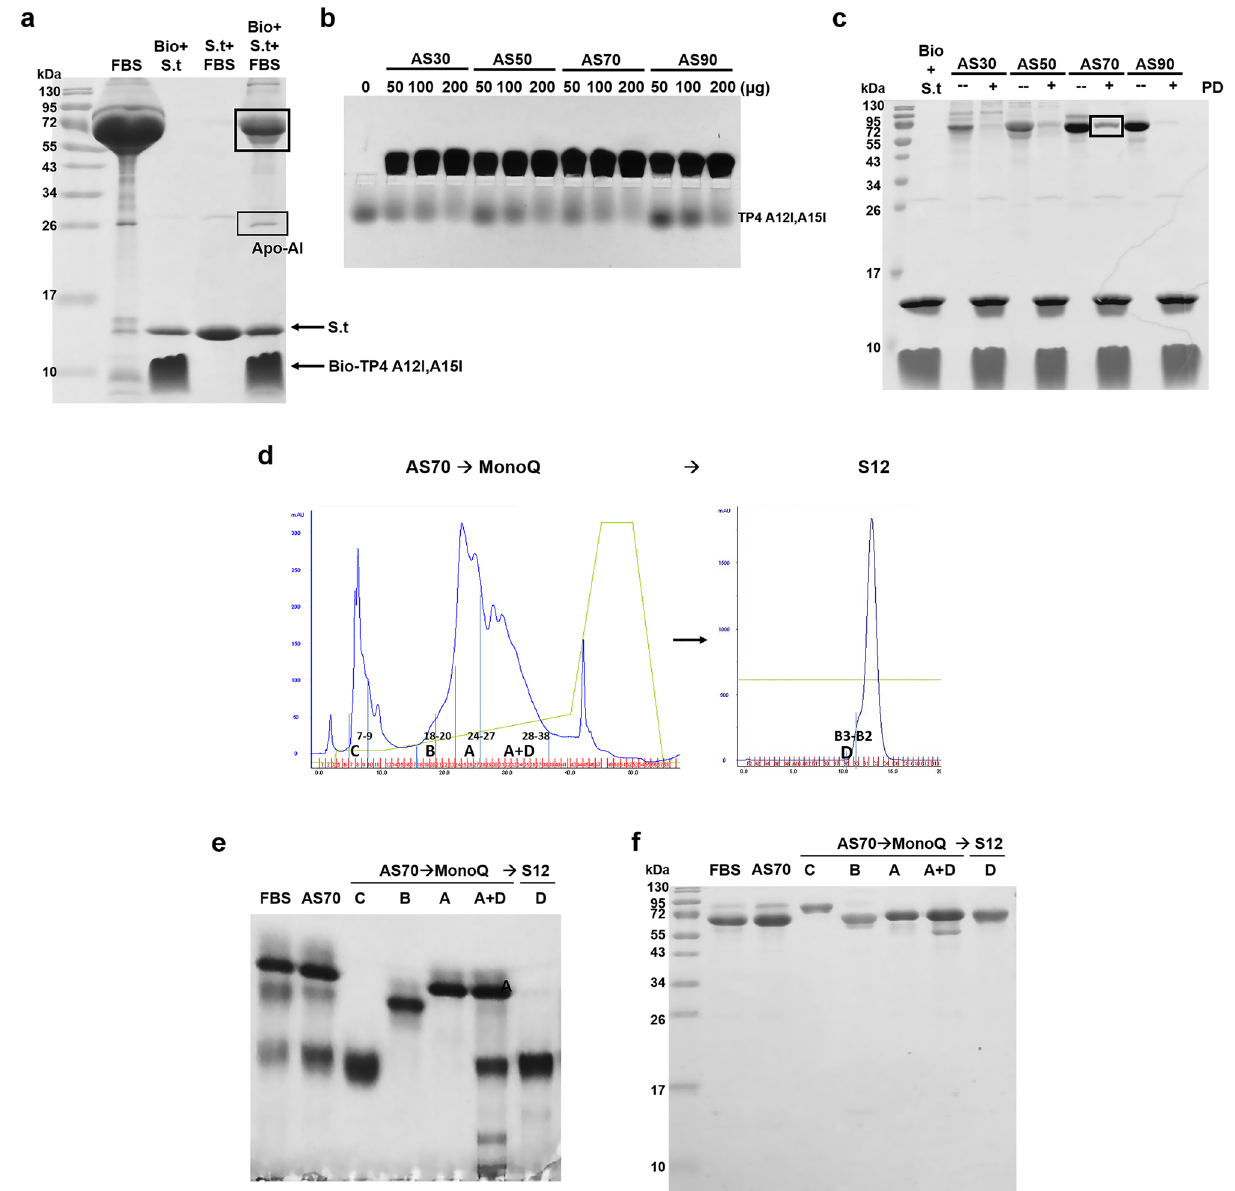
Figure 2. Purification of serum components responsible for AMP-binding. ( a ) Proteins bound to TP4- A12I,A15I peptides. The components in crude bovine serum were pulled down by biotinylated TP4-A12I,A15I peptides which were immobilized on Streptavidin-conjugated beads, and analyzed by 15% reduced SDS-PAGE. ( b ) Band shift of TP4-A12I,A15I peptides by serum proteins after ammonium sulfate fractionation. ( c ) Pulling down of serum proteins after ammonium sulfate fractionation by biotinylated TP4-A12I,A15I peptides which were immobilized on Streptavidin-conjugated beads. ( d ) FPLC chromatography for the purification of serum proteins from 70% saturated ammonium sulfate fractionation. Interested proteins (A, B, C and D) are shown on the profiles of FPLC Mono-Q (left) and S12 (right) column chromatography. ( e , f ) Homogeneity of purified serum components analyzed by horizontal 8% native PAGE, pH8.8, and vertical 15% reduced SDS-PAGE, respectively. Bio, biotinylated TP4-A12I,A15I; S.t., Streptavidin-conjugated beads; PD, pulling down; AS70, fractionation by 70% ammonia sulfate